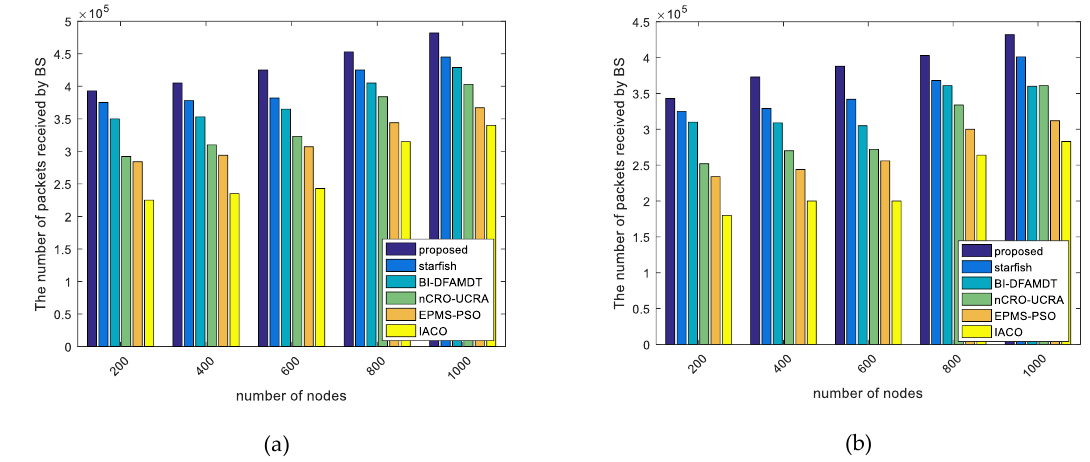
Figure 13. Comparison of the proposed scheme with existing algorithms versus number of packets received by BS: ( a ) Simulation graph for scenario 1; and, ( b ) Simulation graph for scenario 2.